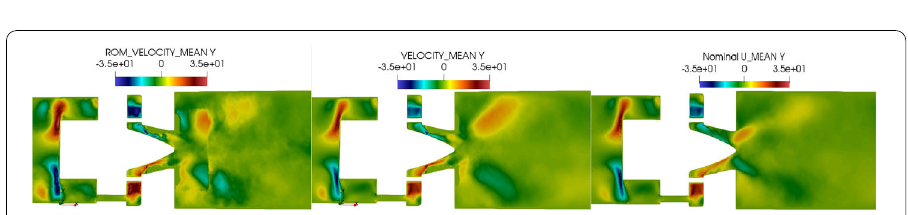
Fig. 41 On the left, the first component of the mean flow field by the UGPOD applied to configuration 1. In the middle, the first component of the high fidelity mean flow field with configuration 1. On the right, the first component of the high fidelity mean flow field with the nominal configuration.